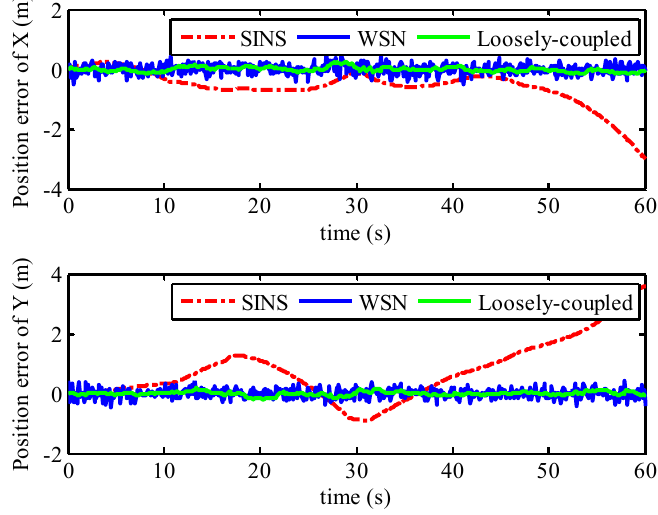
Figure 13. Position error of the SINS/WSN loosely-coupled integration model.